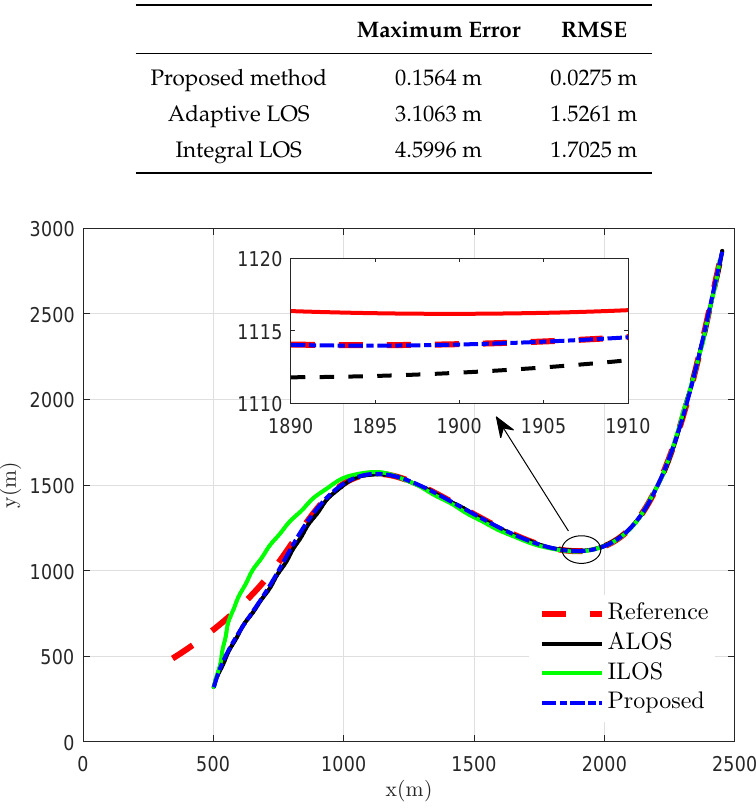
Table 2. Comparisons of path-following performance in steady-state.